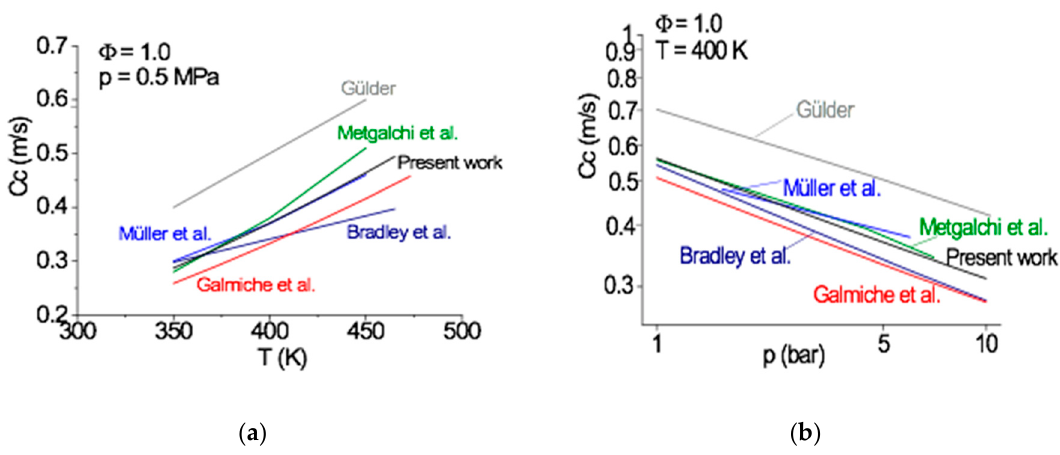
Figure 5. The burning velocity for stoichiometric iso-octane versus temperature ( a ) and pressure ( b ).